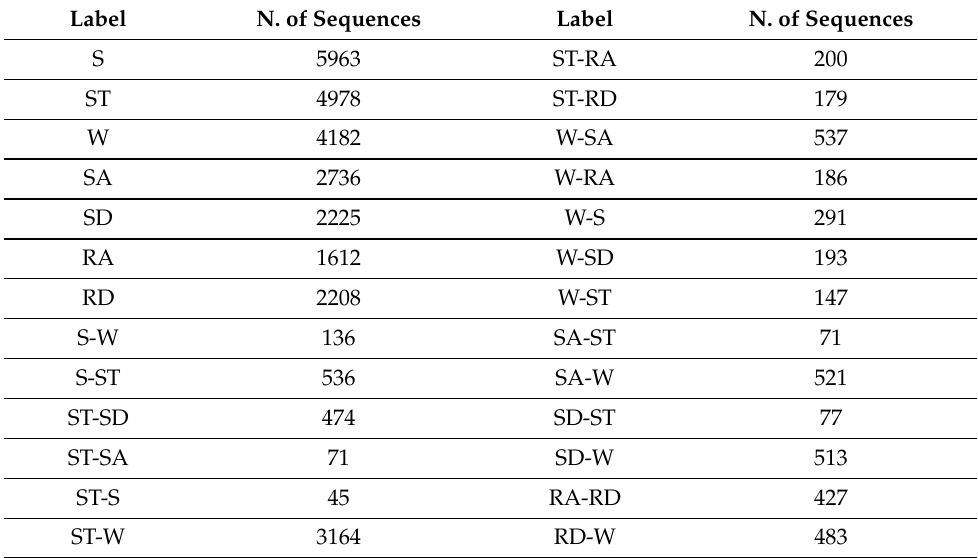
Table 4. Number of sequences for locomotion modes and transitions in the MyLeg data-set. N. of Sequences